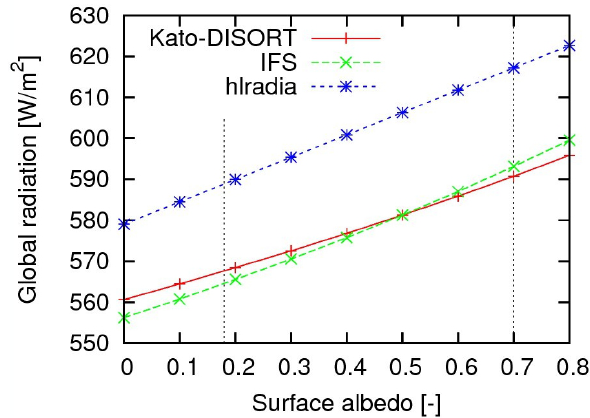
Figure 4. As for Fig. 1 but for the solar zenith angle (experiment 2). The vertical dashed line marks the reference solar zenith angle used in the other experiments. The subplot shows the corresponding rel- ative differences defined as ( X − DISORT)/DISORT · 100%.